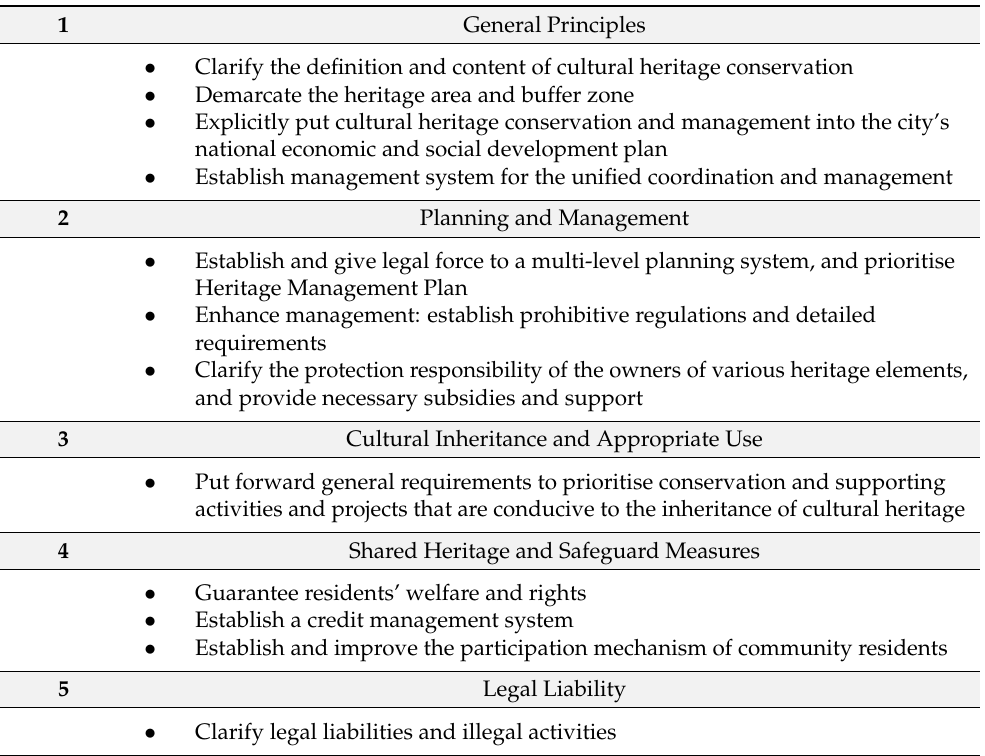
Table 2. Main contents of the Regulations on the Conservation of the Cultural Heritage of Kulangsu, revised in